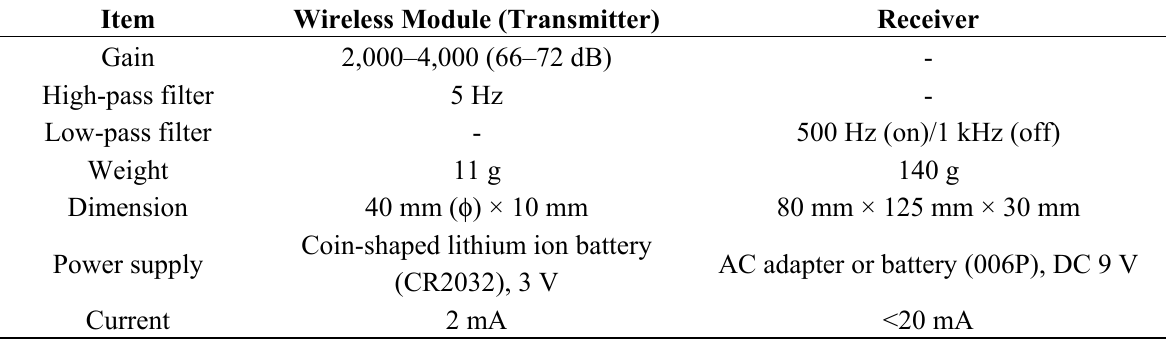
Table 1. Specifications of the developed wireless electrode module.